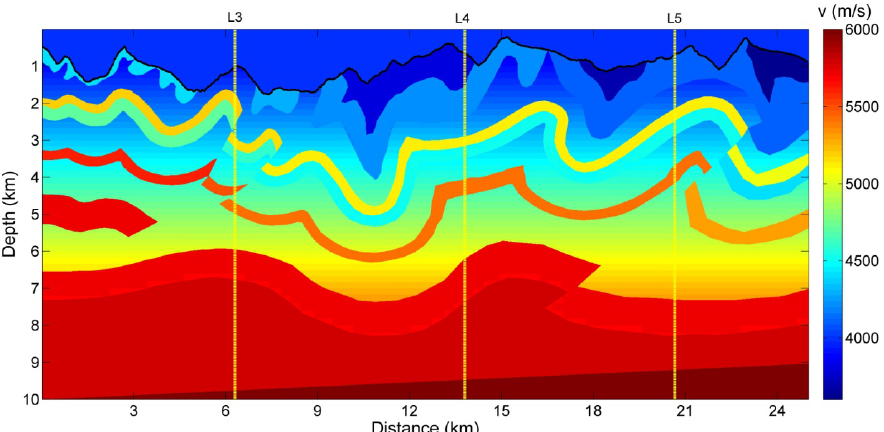
Figure 10. The velocity field of the Canadian Foothills model. The yellow lines show the locations of log L3, log L4, and log L5.